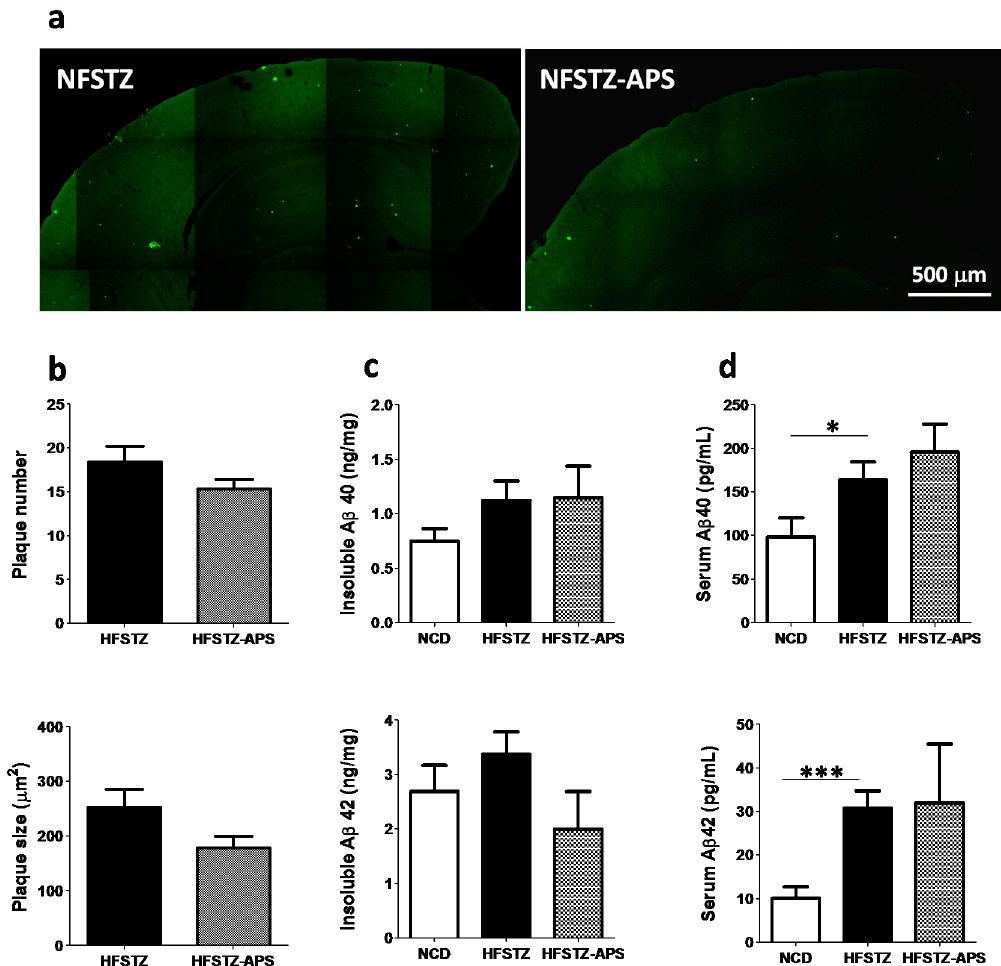
Figure 5. APS did not ameliorate HFSTZ-aggravated cerebral A β deposition and serum A β . APP/PS1 mice were treated with HFSTZ ( n = 5) or HFSTZ-APS ( n = 6); ( a ) Representative images of 1-bromo-2,5-bis-(3-hydroxycarbonyl-4-hydroxy) styrylbenzene (BSB)-positive plaques in the cerebral cortex of HFSTZ and HFSTZ-APS mice (scale bar, 500 µ m); ( b ) Plaque size and plaque number in a single hemisphere were calculated using Metamorph analysis software. APP/PS1 mice were treated with NCD ( n = 14), HFSTZ ( n = 15) or HFSTZ-APS ( n = 7); ( c ) Levels of soluble and insoluble form A β 40 and A β 42 in cerebral cortex were measured by enzyme-linked immunosorbent assay (ELISA); ( d ) The Serum A β 40 and A β 42 levels were measured using ELISA. Bars represent the mean ± SEM of four independent experiments. Data are shown as mean ± SEM. * p < 0.05, and *** p < 0.001, significant difference from HFSTZ group.